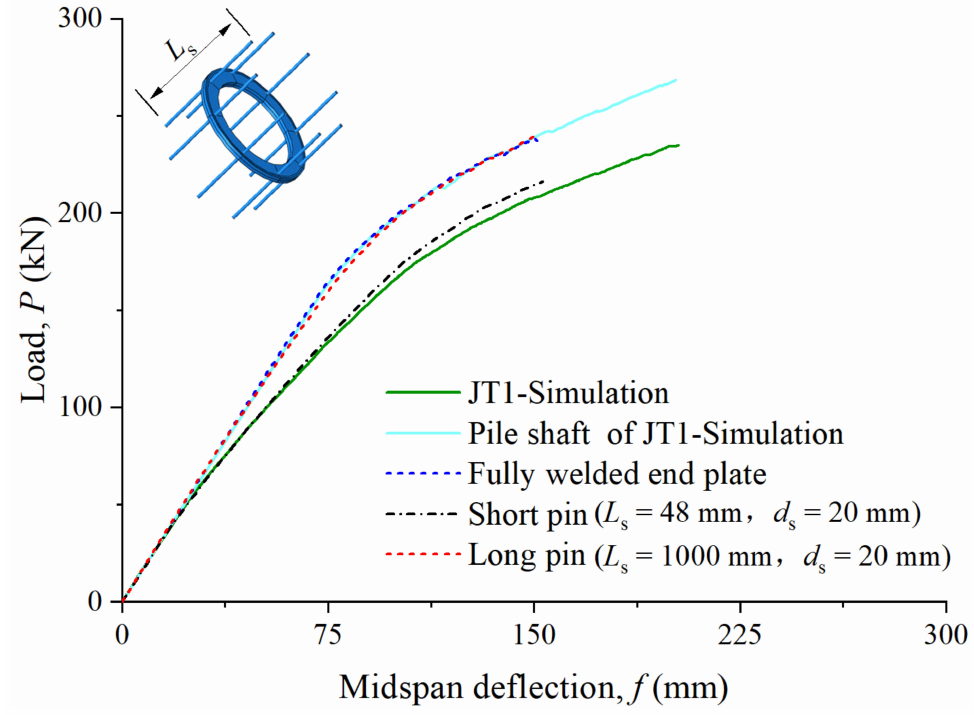
Figure 15. Influence of connection mode on the bending strength of